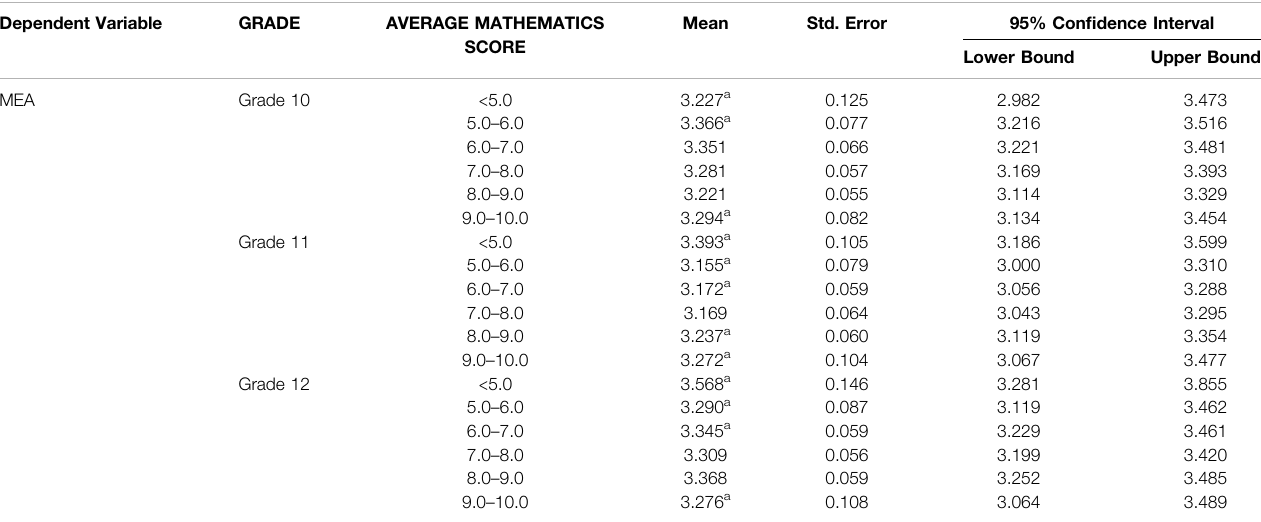
TABLE 4 | The mean scores of students in